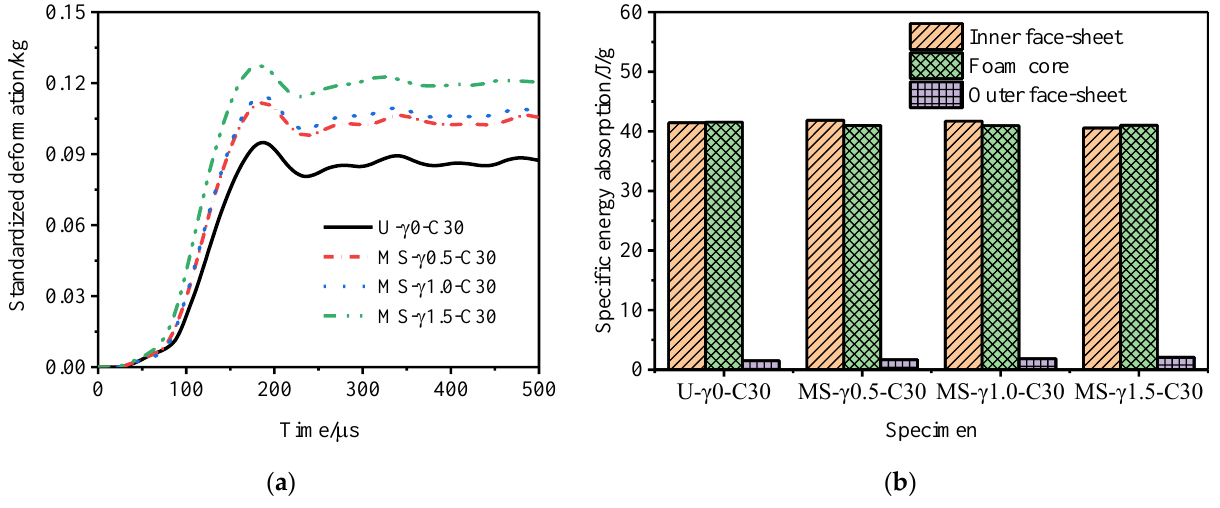
Figure 17. Anti − explosion performance of an MH-type aluminum foam sandwich tube. ( a ) Defor- mation curve of the outer tube and ( b ) specific energy absorbed by the sandwich tube.